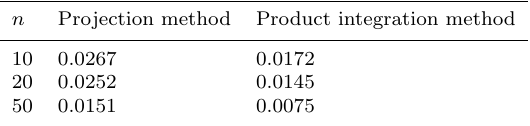
Table 2. Relative